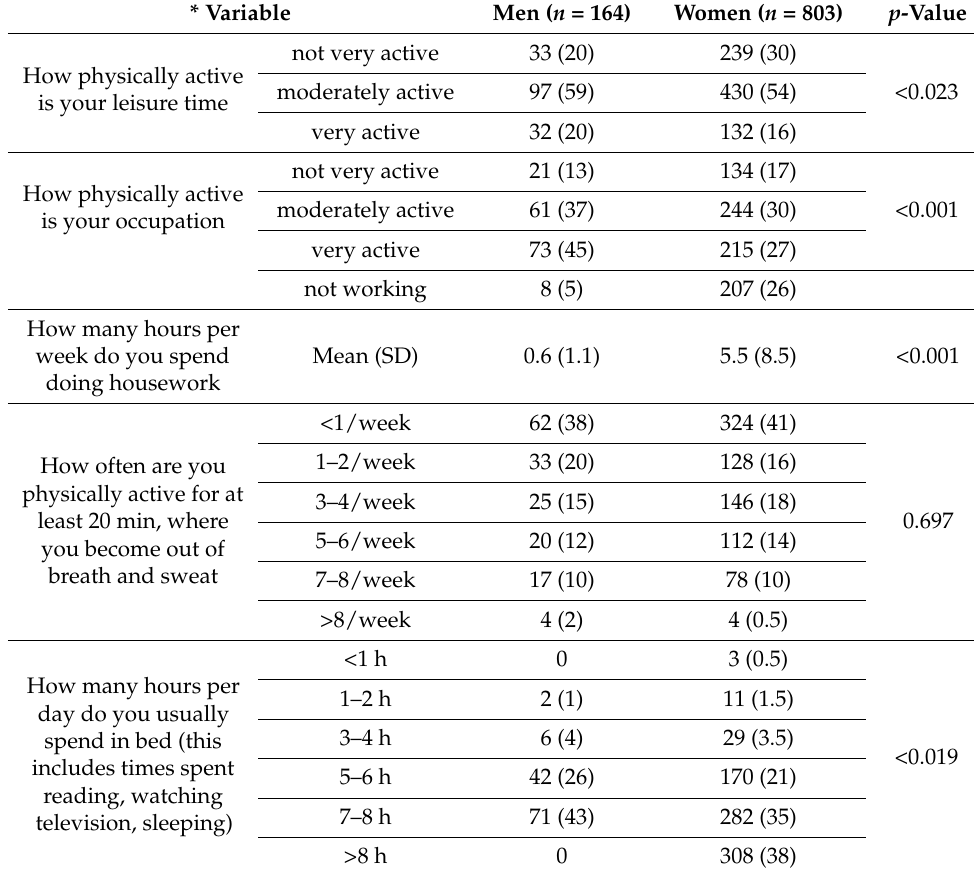
Table 1. Baseline exercise diary of men and women, number (%).